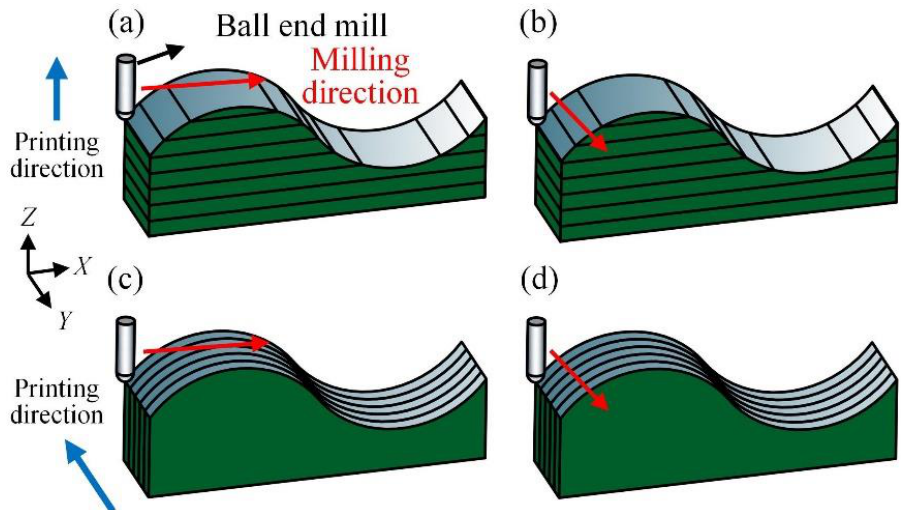
Figure 2. Specimens milling methods: ( a ) 0° printing, milling at the X direction; ( b ) 0° printing, milling at the Y direction; ( c ) 90° printing, milling at the X direction; ( d ) 90° printing, milling at the Y direction.